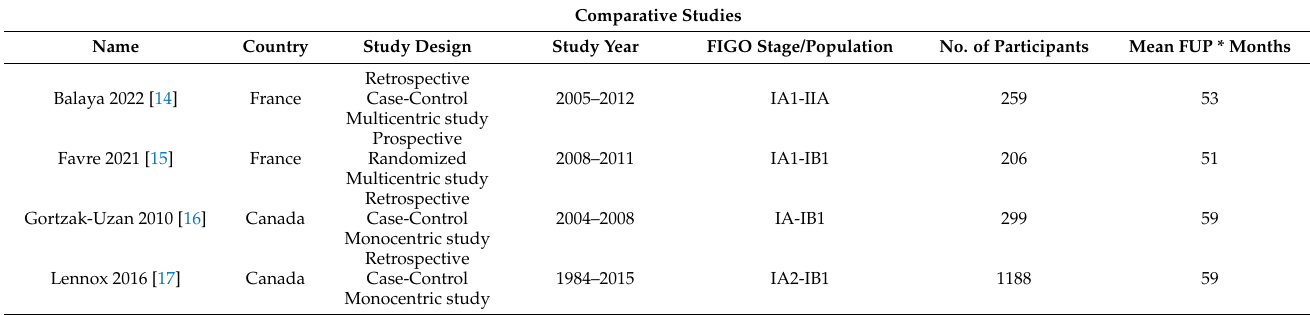
Table 1. Studies included.